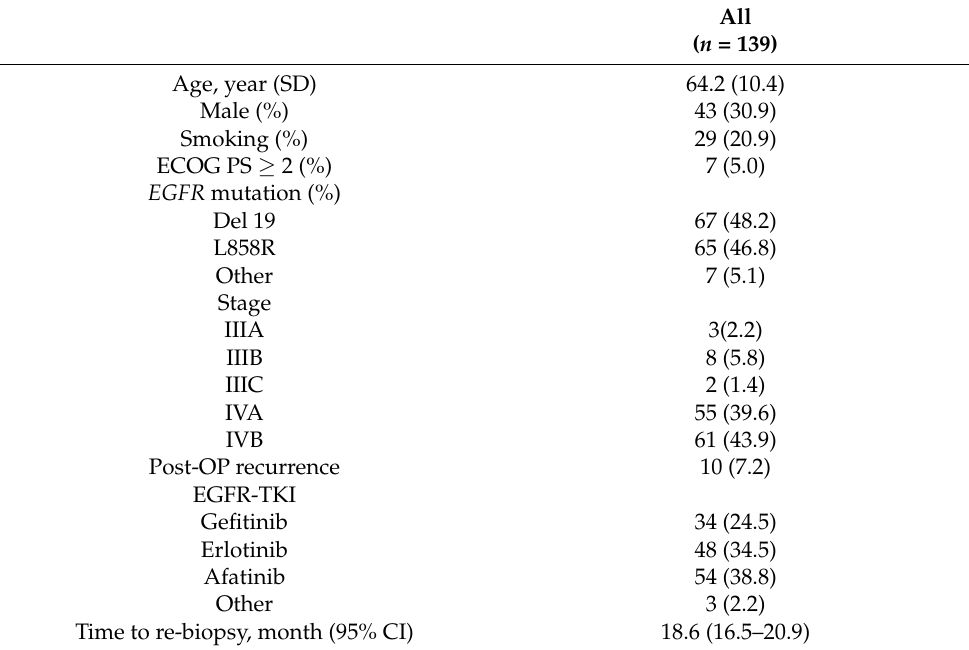
Figure 2. Flowchart showing the rate of detection of the T790M mutation in EGFR mutation-positive non-small-cell lung cancer patients at repeat re-biopsies. Table 1. Characteristics of patients enrolled in this